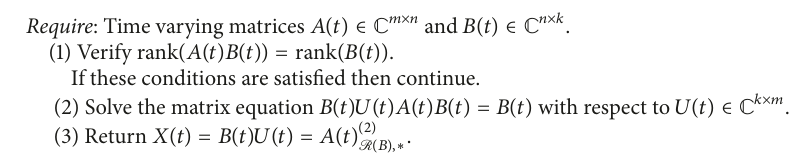
Algorithm 1: Computing an outer inverse with the prescribed